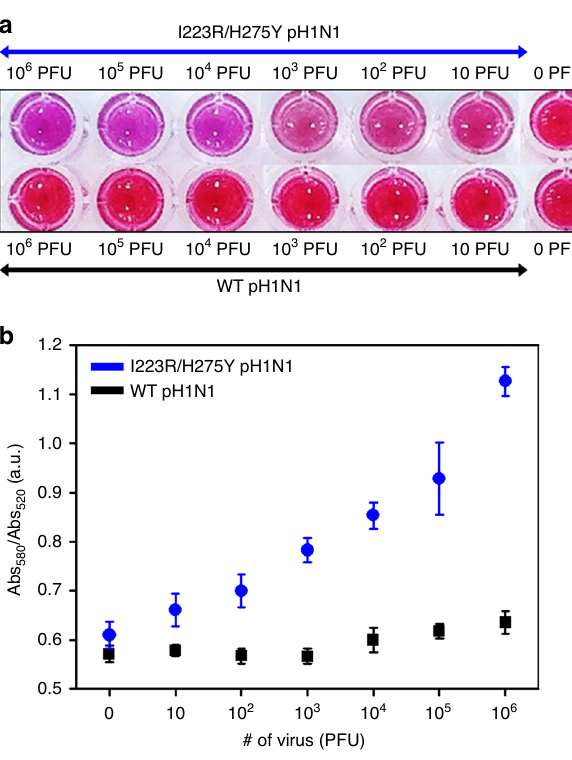
Fig. 5 Colorimetric detection of I223R/H275Y pH1N1 using A4. a Optical images of A4-Au NPs in the presence of I223R/H275Y pH1N1 (upper panel) and wt pH1N1 (lower panel). Each experiment was repeated three times independently with similar results. b Plot of Abs 580 /Abs 520 versus the number of in fl uenza virus. Data represent the average plus/minus standard deviation from three measurements.